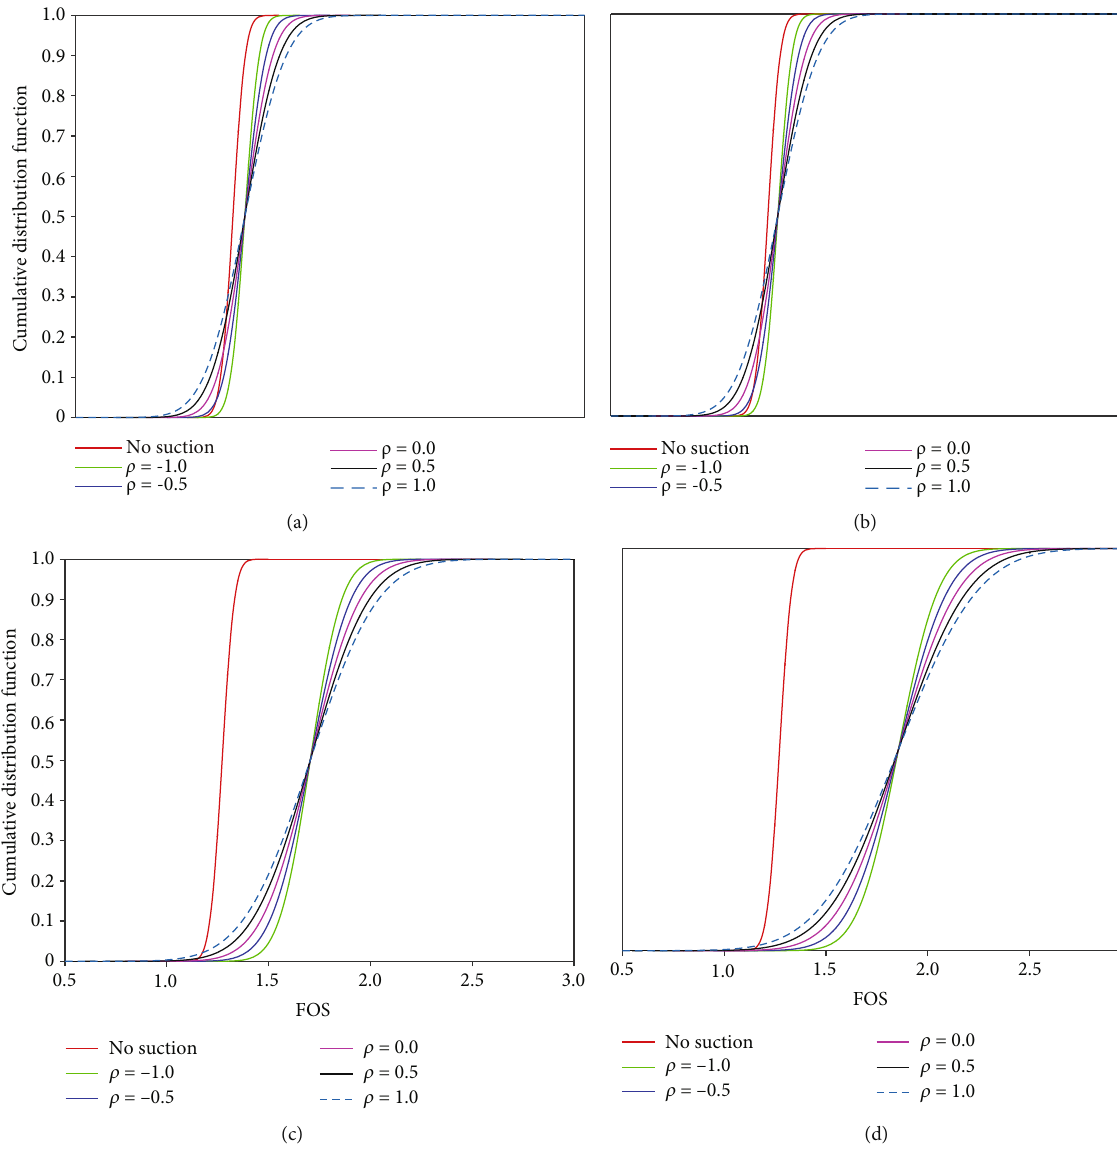
Figure 5: CDFs for di ff erent soils: (a) sandy soil; (b) fi ne-grained soil; (c) clays; (d) extremely fi ne-grained